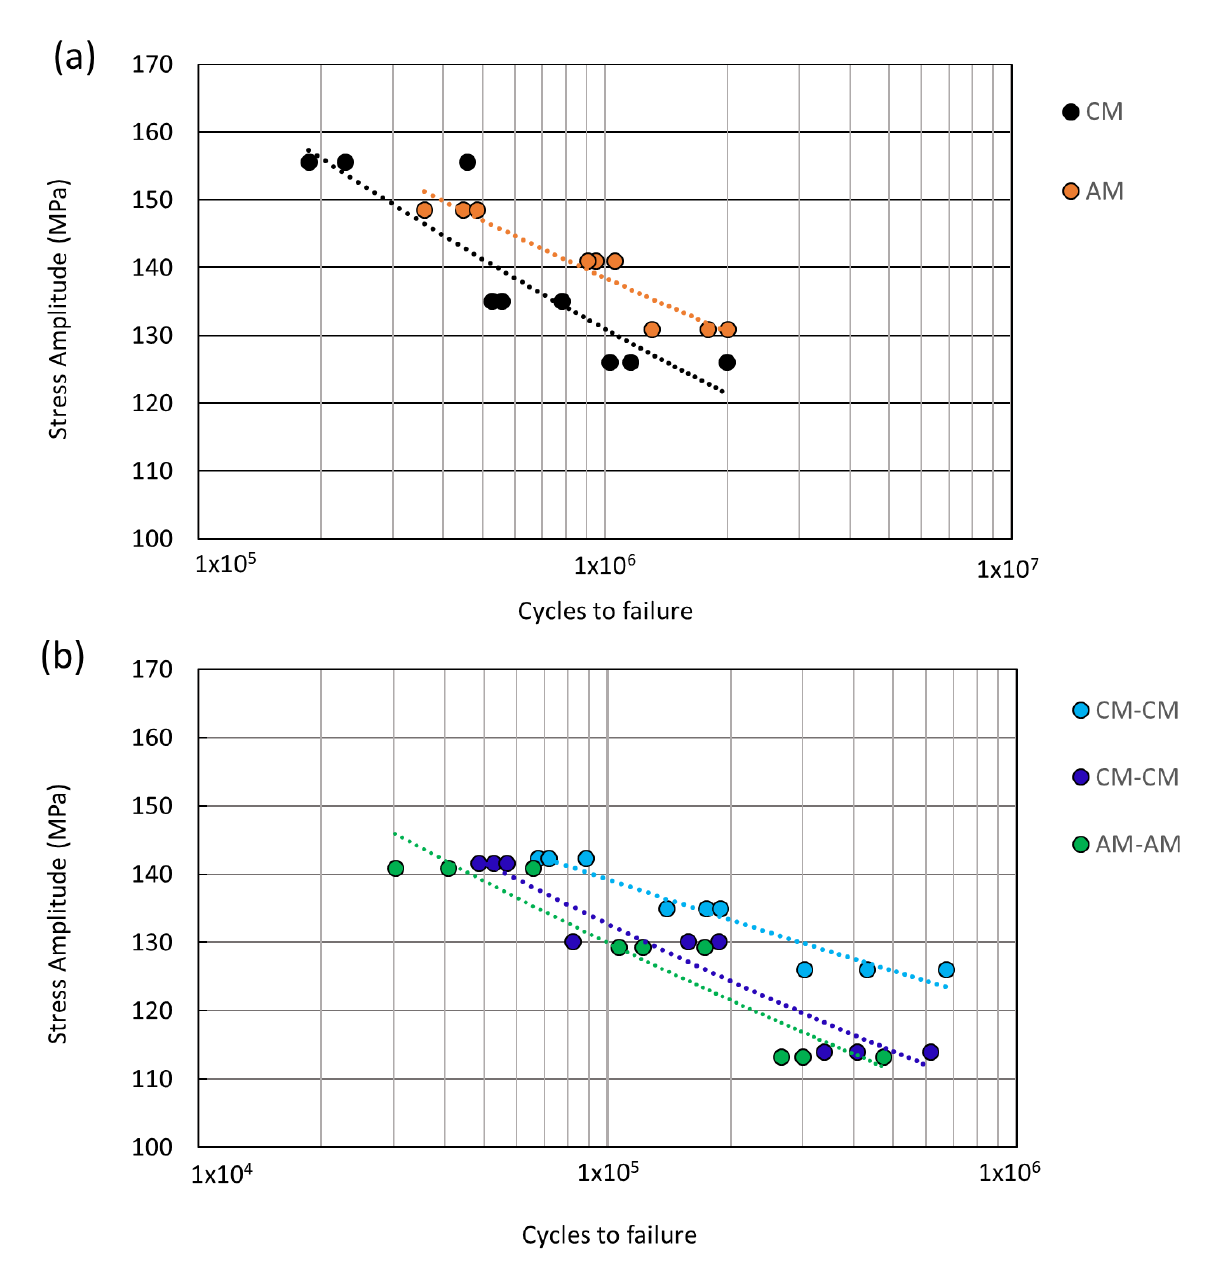
Figure 16. Fatigue finite life range: ( a ) Non-welded specimens (CM, AM), ( b ) welded parts (CM-CM, CM-AM, AM-AM).